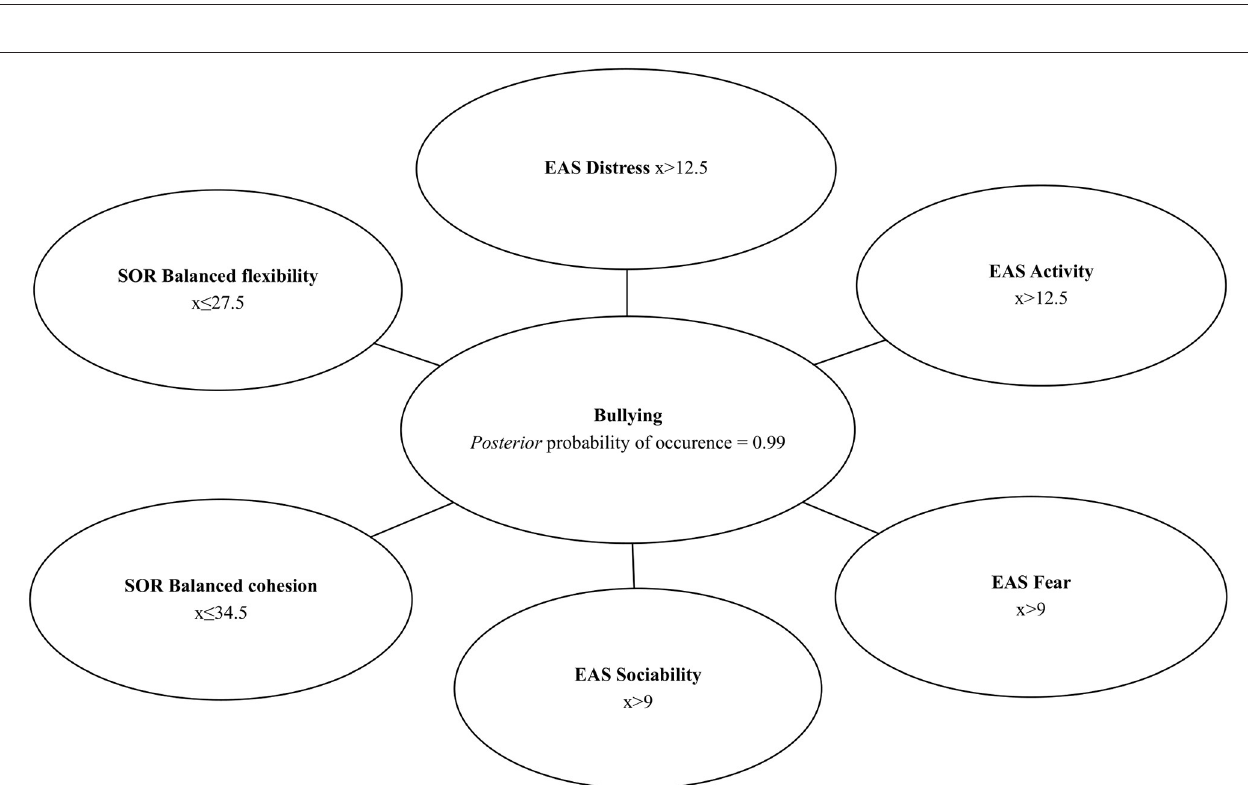
FIGURE 3 | Bayesian network–high posteriori conditional probability of